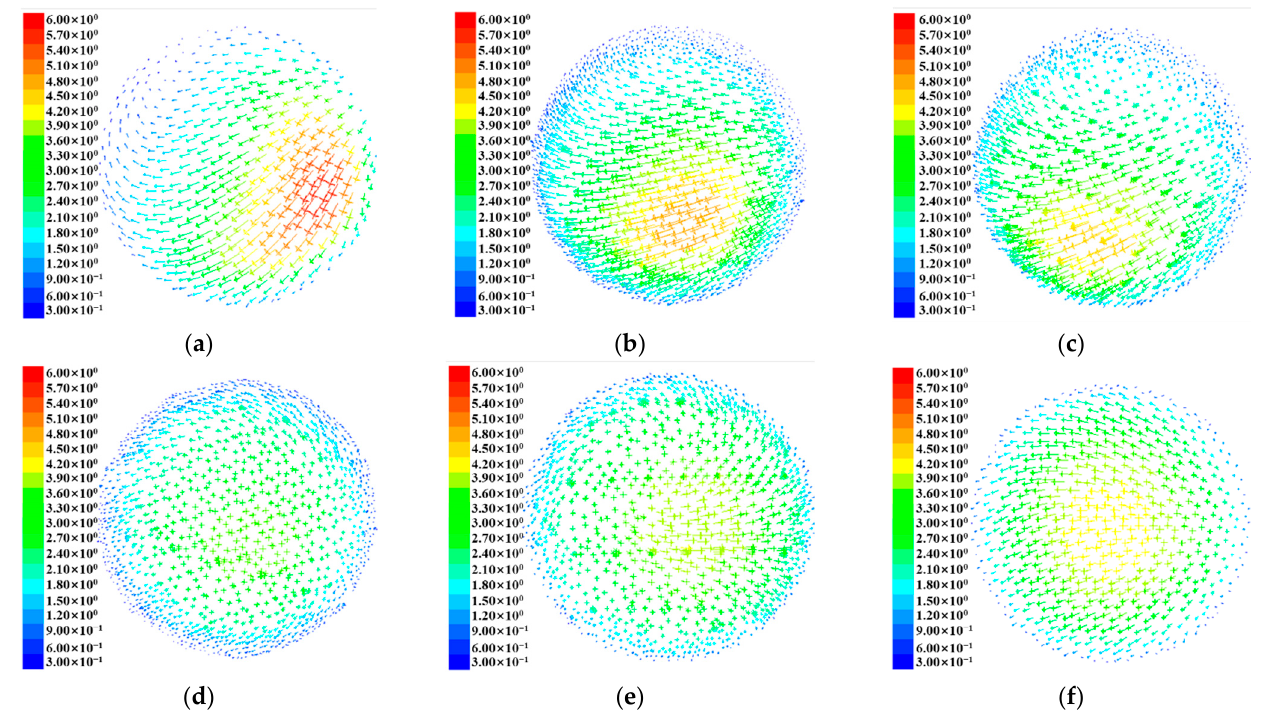
Figure 15. The velocity vector diagram of the crushed straw material phase in each radial section of the air-conveying cylinder area. ( a ) The inlet section of the straight feed pipe. ( b ) The middle section of the straight feed pipe. ( c ) The outlet section of the straight feed pipe. ( d ) The middle section of the elbow. ( e ) The outlet section of the elbow. ( f ) The cross section of the outlet of the straight pipe. (2) From the outlet of the straight feeding pipe to the middle section of the elbow, the the middle part. At the same time, the maximum speed dropped from 4.5~4.8 m/s to